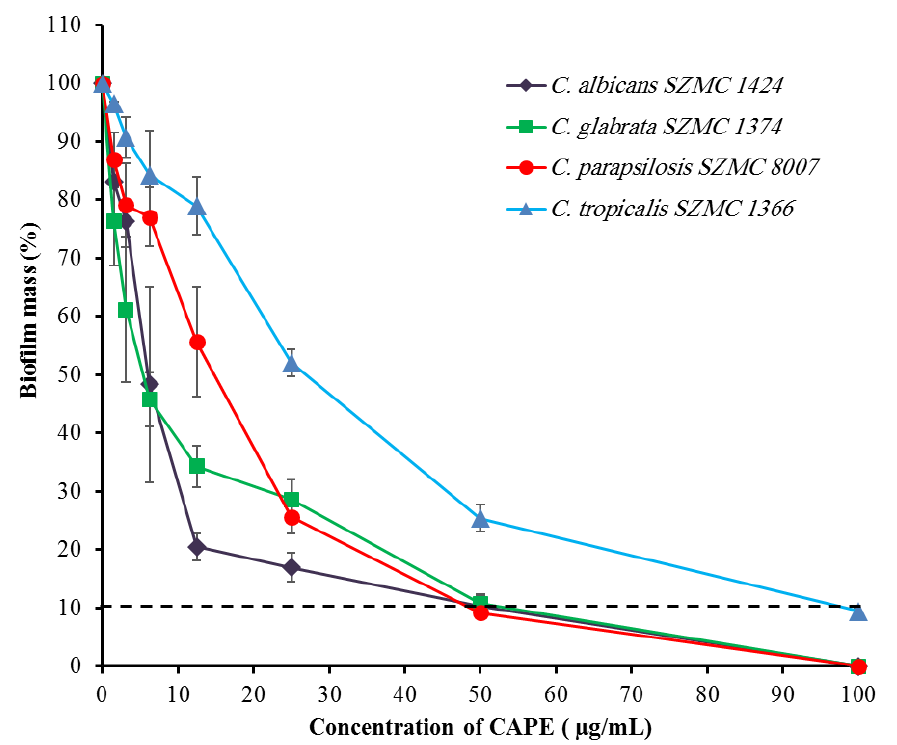
Figure 1. Effect of CAPE on the biofilm-forming ability of four Candida species. The dashed line represents the MBIC. Data are shown as mean ± SD from three independent experiments.